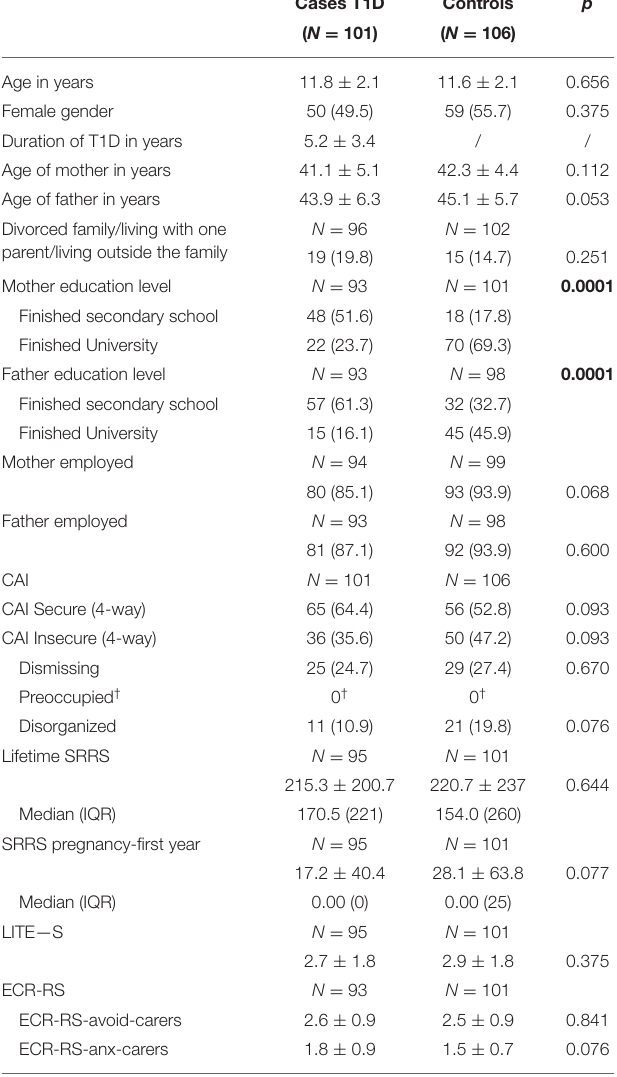
TABLE 1 | Demographic data and results of the measured attachment to the mother, child stressful life events, family stressful events, and carers’ attachment for children with T1D and healthy